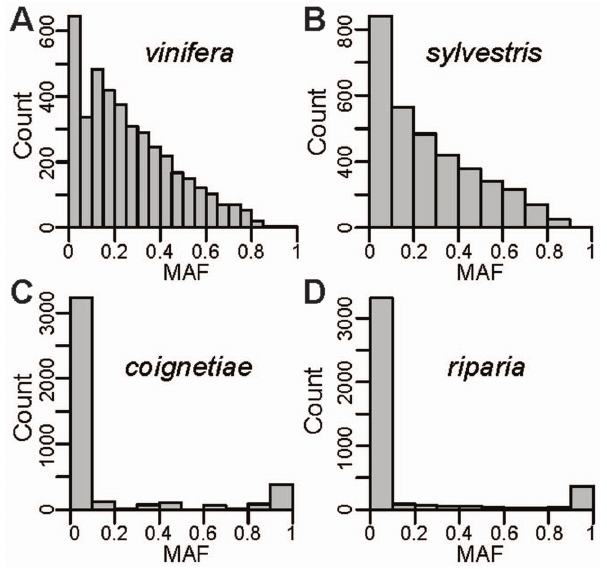
Figure 2. Minor allele frequency (MAF) for vinifera and sylvestris and two representative taxa, V. coignetiae from Asia and V. riparia from North America. MAF allele frequencies for other species look similar to V. coignetiae and V. riparia with a severe deficit of intermediate frequency alleles compared to vinifera and sylvestris .